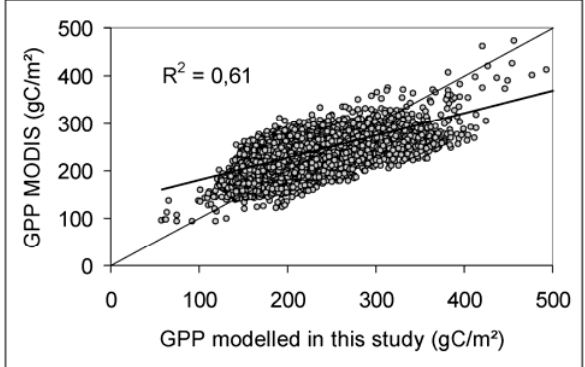
Figure 5. Pixel-by-pixel relationship between MODIS GPP and the GPP modelled in this study. Points represent individual pixels (1 × 1 km, n = 31500). The thin line represents 1:1 line, while the thick one is the regression line between the data